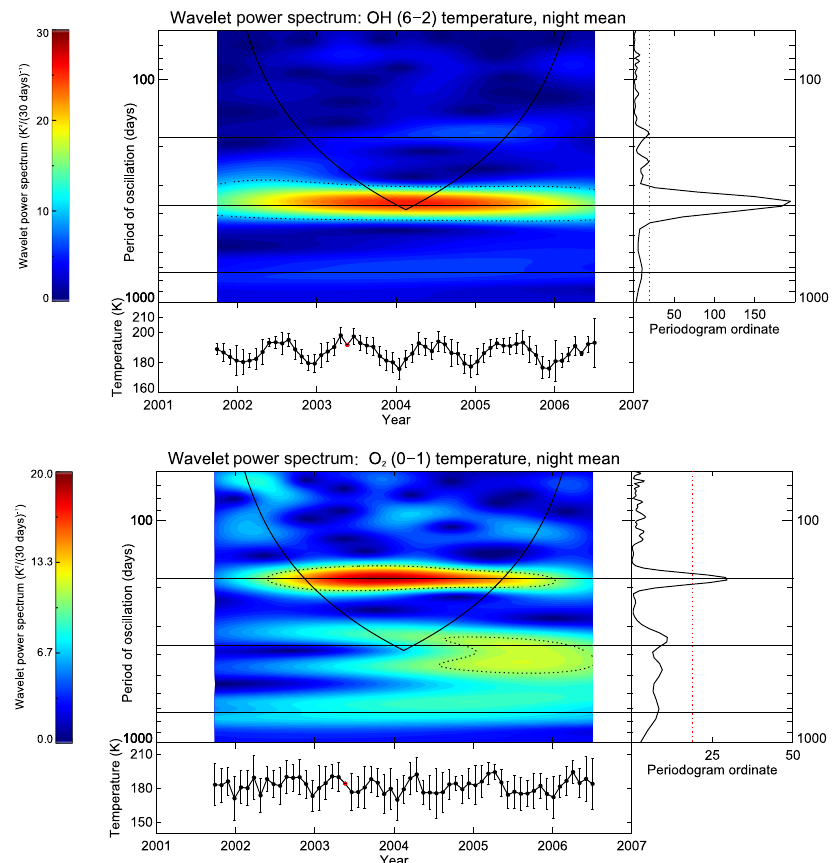
Figure 3. Top: the wavelet power spectrum for the OH(6–2) temperature (top) with the time series of 30-day averaged values and their standard deviations (bottom) and the corresponding Lomb periodogram (right). The periods of the SAO, AO, and QBO are indicated by the horizontal grey lines. The time series is dominated by the AO, which is consistent across the observational period in amplitude and phase. The SAO is present in the second half of the observational period and the QBO at its centre. Bottom: as for top panel, but for the O 2 (0–1) temperatures. The SAO is the dominant periodicity in this times series, with more power in the AO later in the observational period. There is power in the wavelet spectrum at the period of the QBO, particularly after 2003, but not at a significant level when averaged over the entire observational